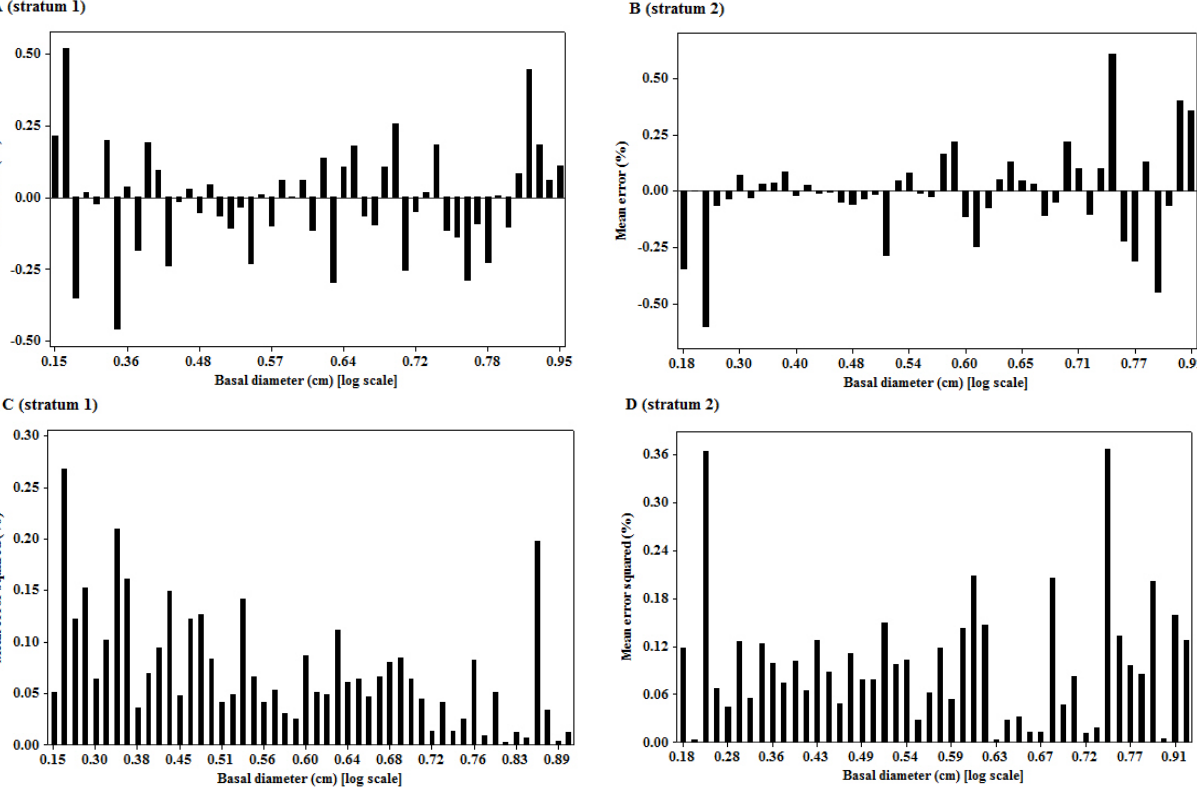
Figure 3. Disaggregation of prediction errors by tree sizes. A and B = mean prediction errors (MPE%); C and D = Root mean squared error